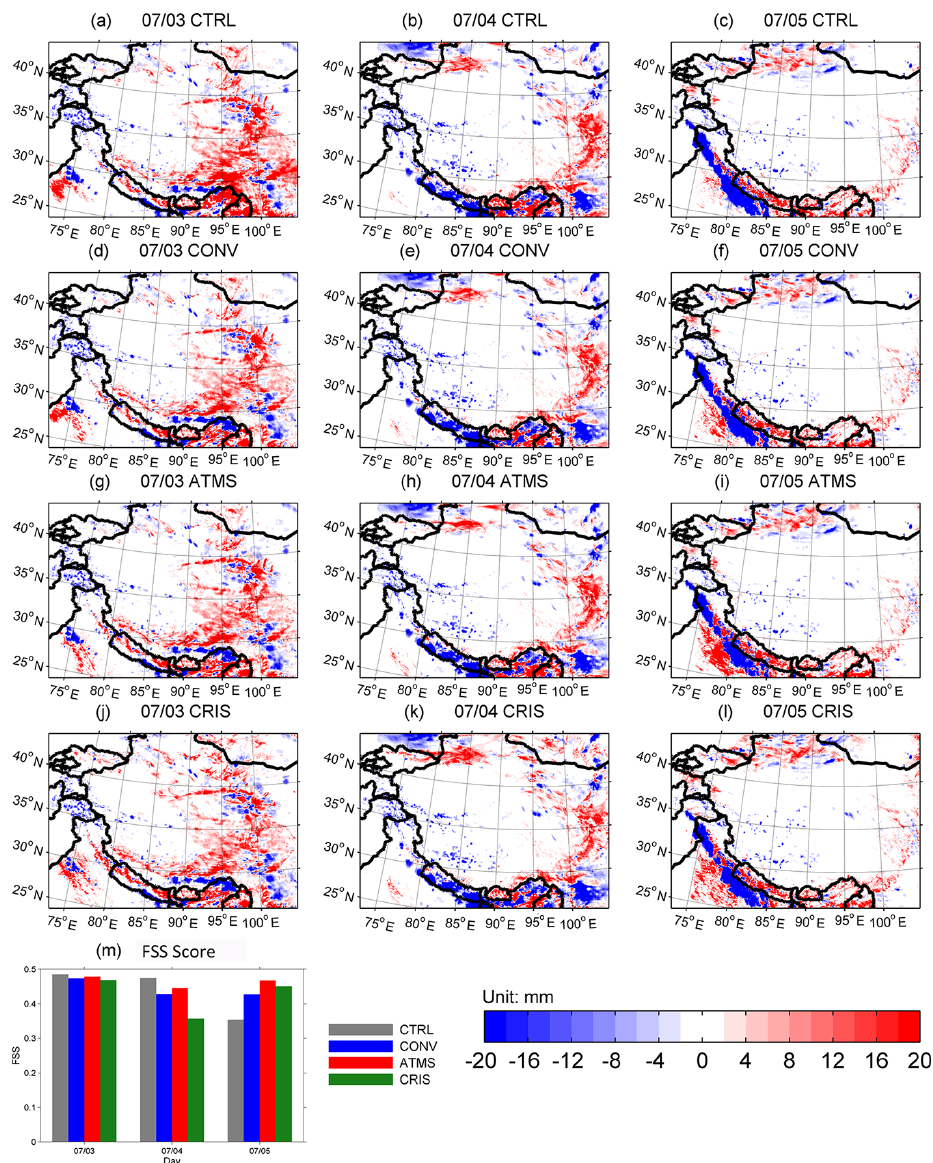
Figure 11. (a–l) are differences between the simulated F24H precipitation and the observed distribution, and (m) is the FSS skill scores with a 8mmday − 1 threshold during 3–5 July. The unit of differences is